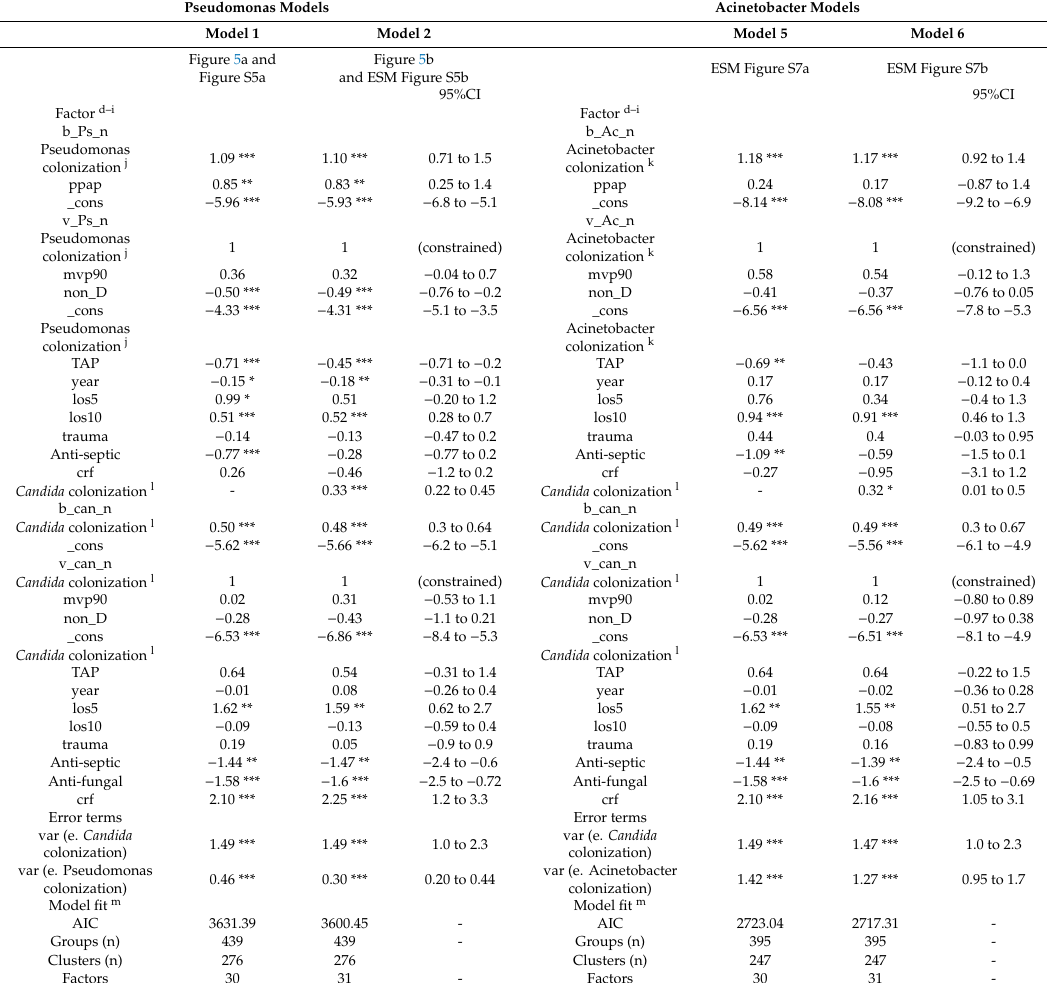
Table 2. Development of GSEM model a, b, c .